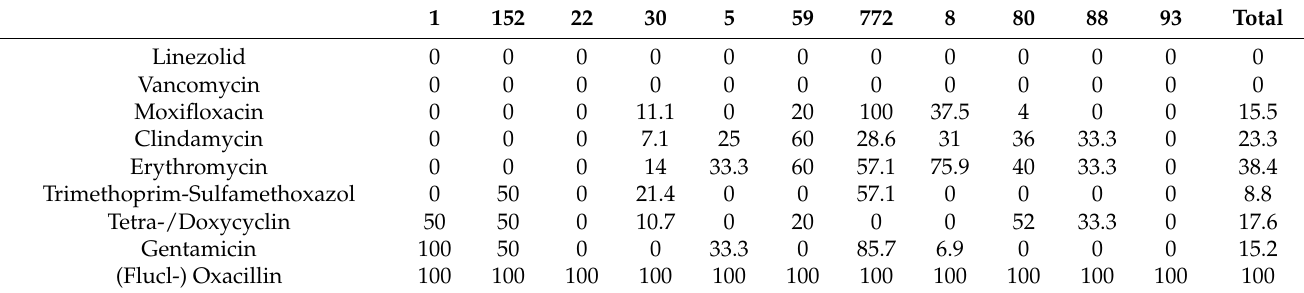
Table 1. Overview of resistances (in %) to antibiotics for each clonal complex and overall resistance rates. The upper line denotes the number of the clonal complex